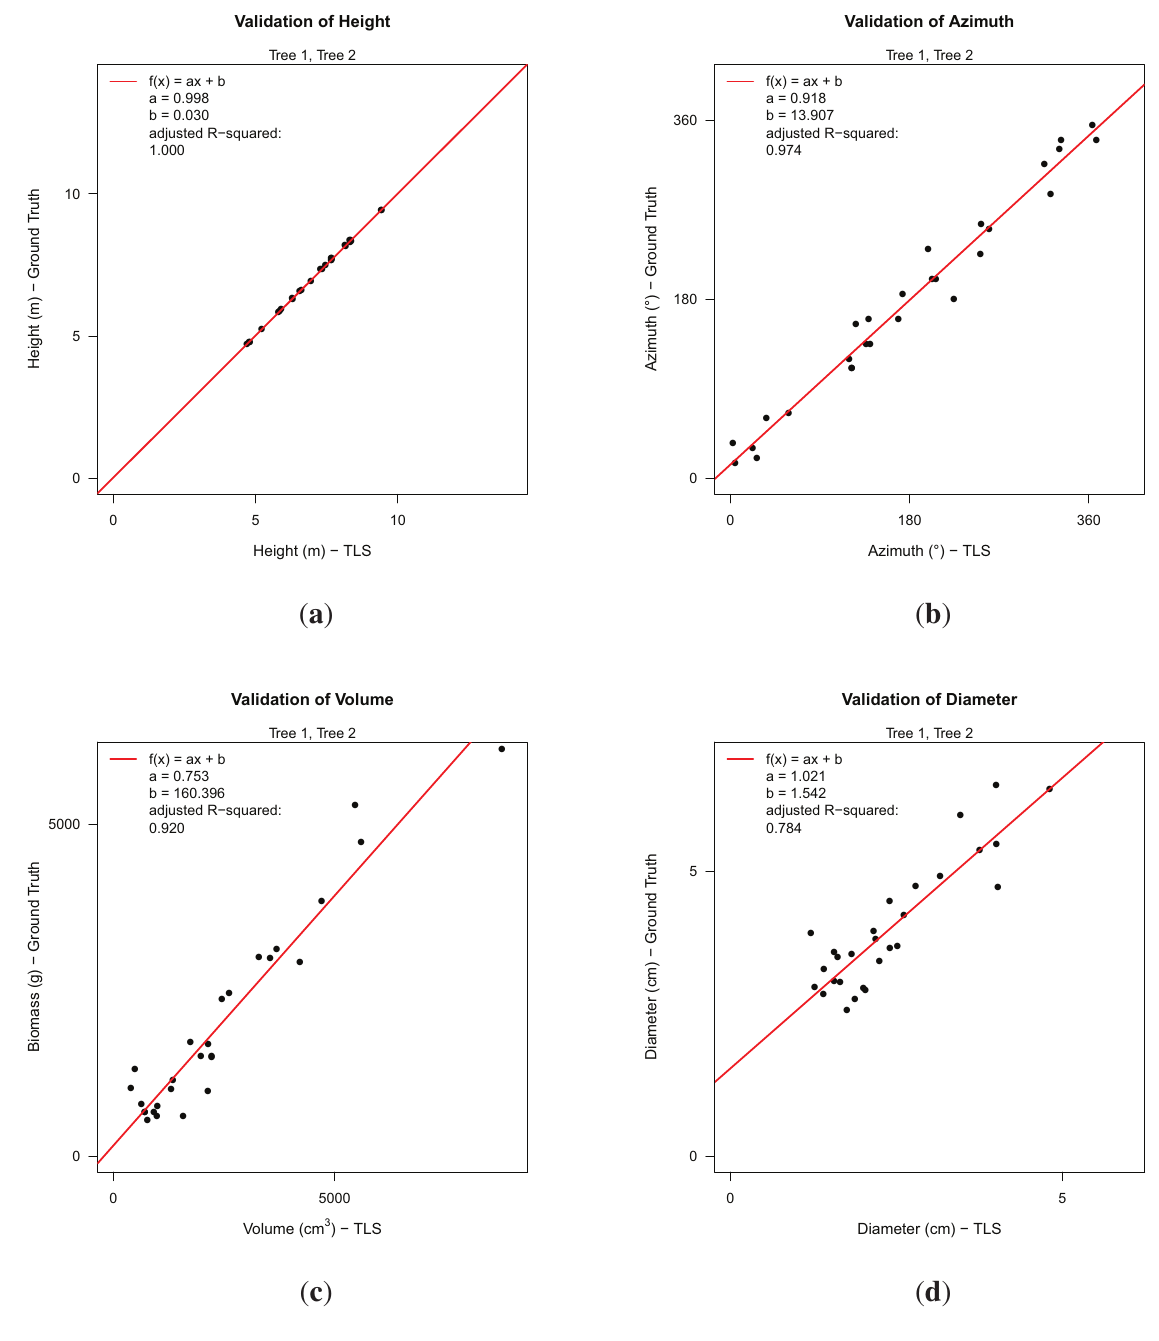
Figure 7. Analysis between TLS-derived data and ground truth data for 28 branches with respect to: (a) branch height; (b) azimuthal direction of branches; (c) TLS-volume against biomass (fresh weight); (d) diameter at branch